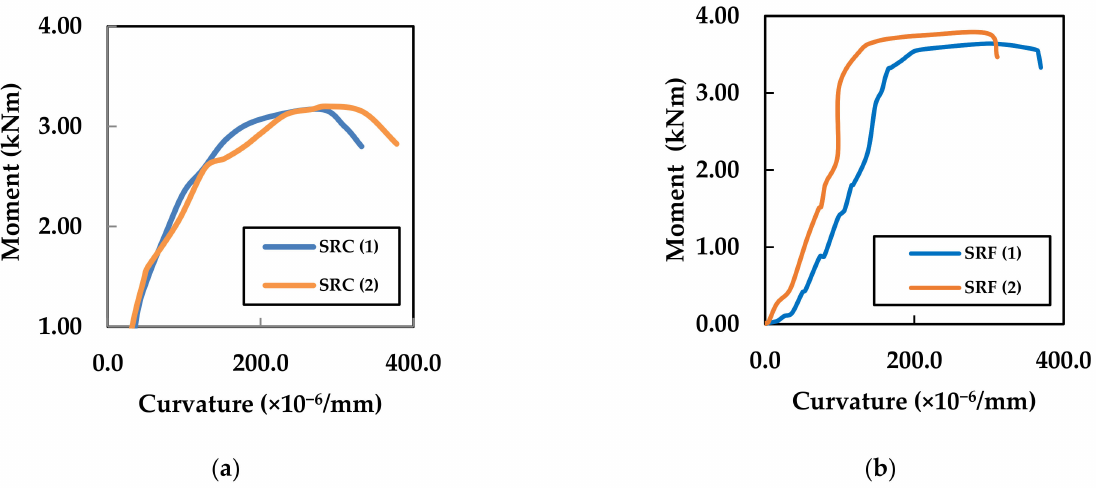
Figure 19. Moment–curvature behaviour of ( a ) SRC and ( b )